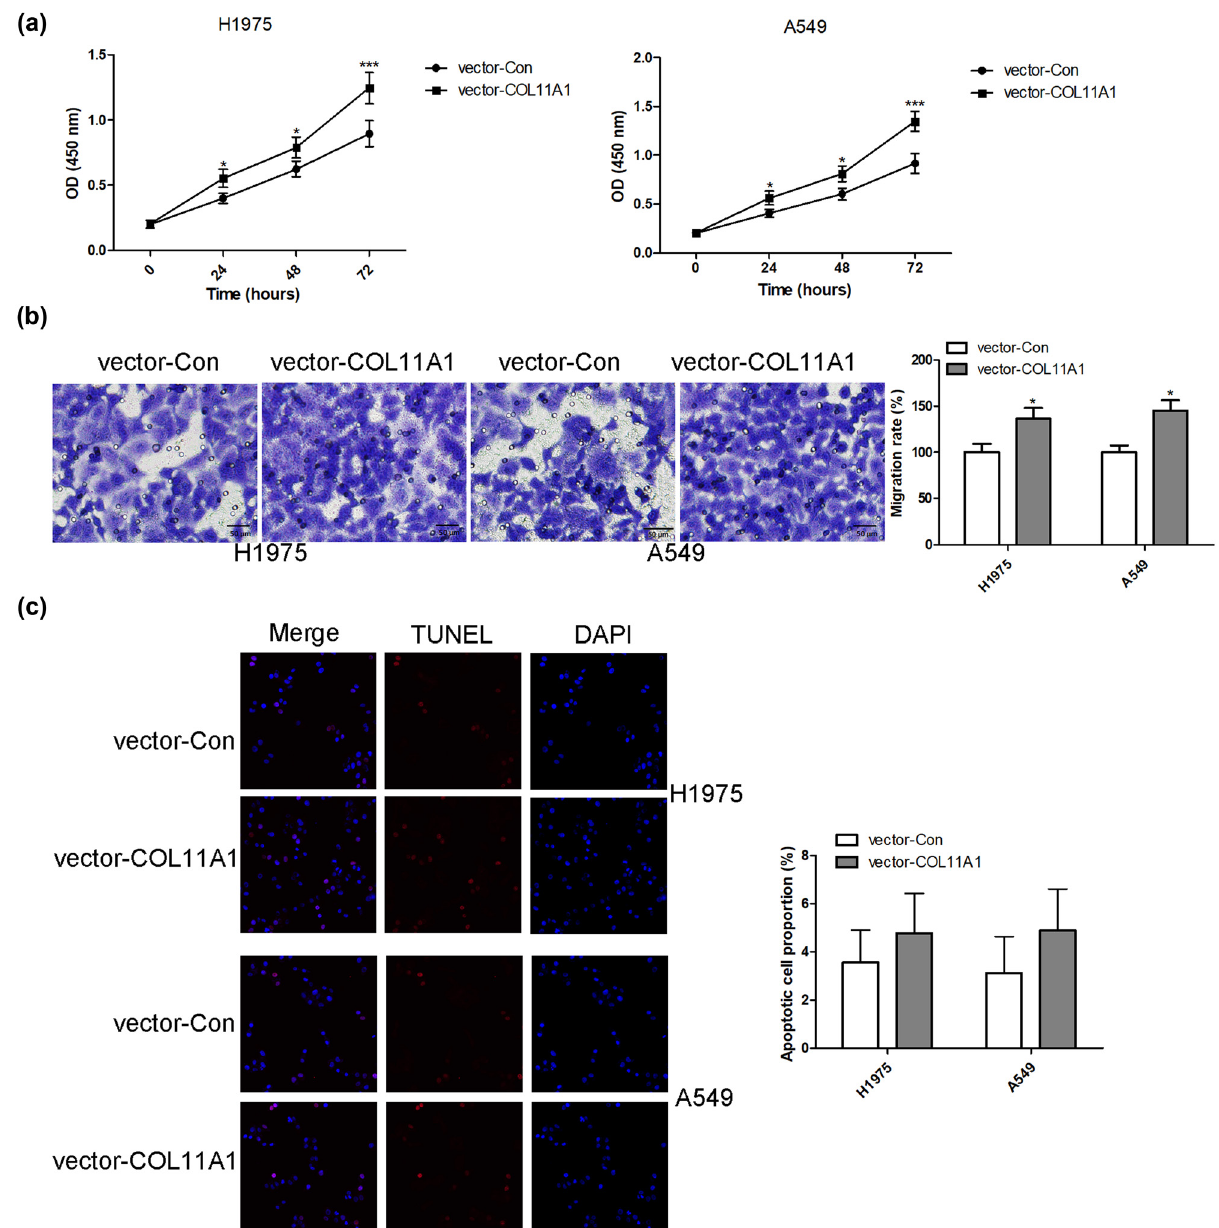
Figure A2: Overexpression of COL11A1 promotes malignant phenotypes of LUAD cells. After transfection with vector - Con or vector - COL11A1 into H1957 and A549 cells, cell growth, migration and apoptosis were evaluated by CCK8 ( a ) , transwell ( b ) and TUNEL ( c ) assays, respectively. ∗ P < 0.05 compared with control